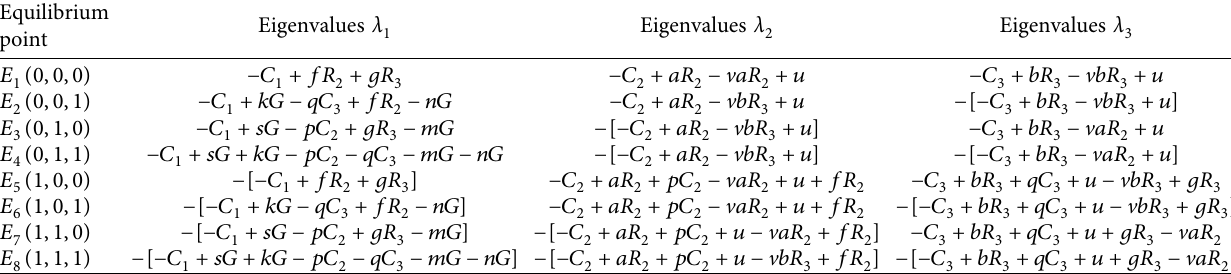
Table 3: Eigenvalues corresponding to the equilibrium